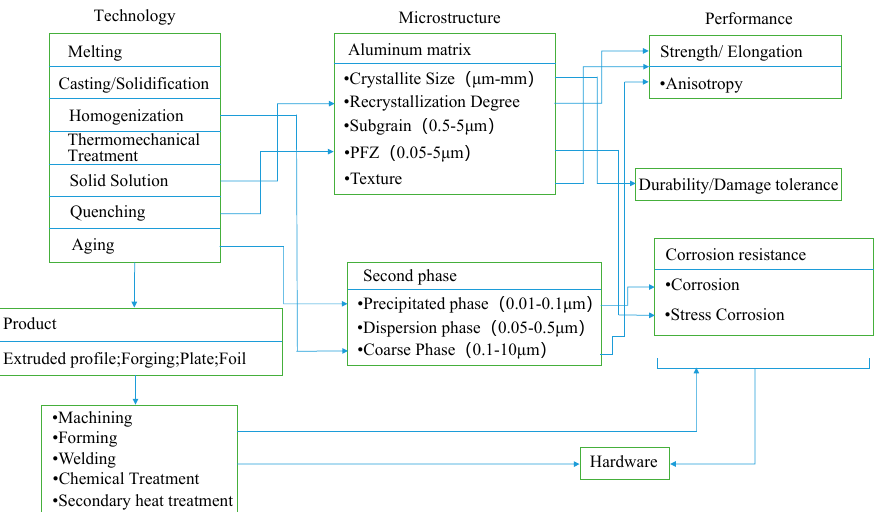
Figure 18. Technology microstructure performance relationship of 7xxx series aluminum alloy. Adapted with permission from ref. [79]. 2019 Deng and Zhang.